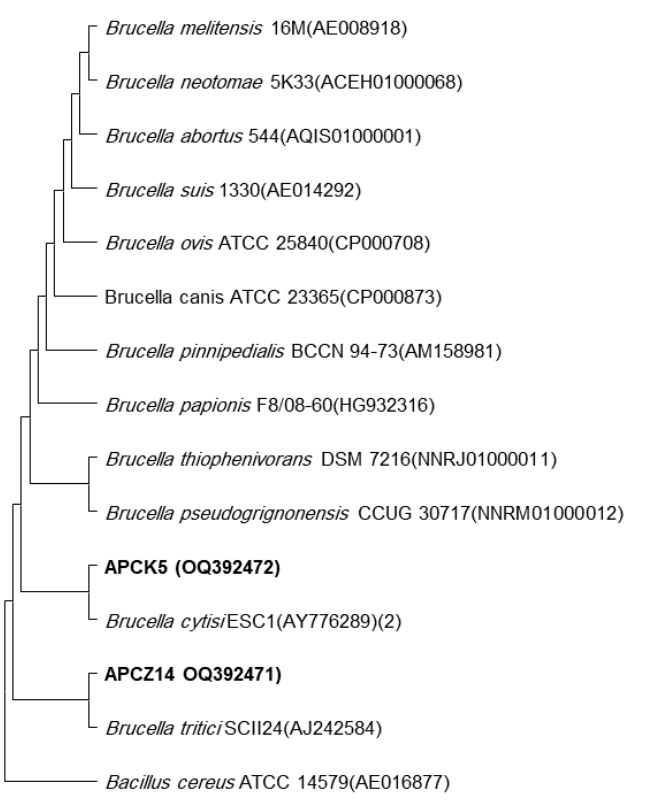
Figure 2. Evolutionary relationships of taxa.